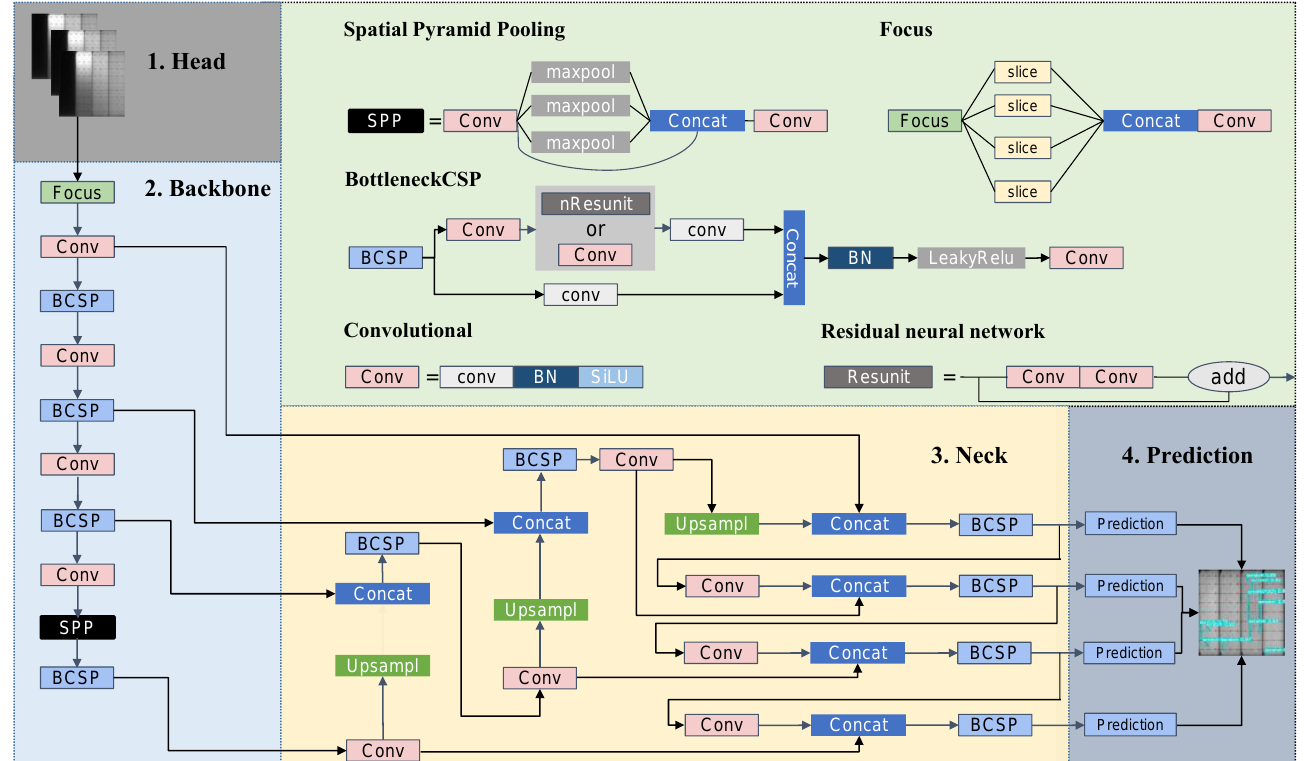
Figure 1. The framework of PV panel surface-defect detection network. Using the BottleneckCSP module in the backbone network and neck network ensures that deeper semantic information of PV panels can be extracted, and a tiny target detection head is added at the prediction end so that the PV panel missed detection phenomenon is improved. Replacing the traditional convolution with Ghost convolution can guarantee the accuracy of PV panel detection without losing